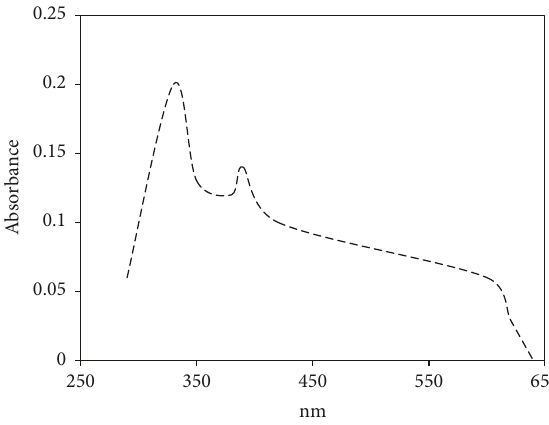
Figure 1: UV spectrum of PVC modified by N -(4-BrPh)IM.